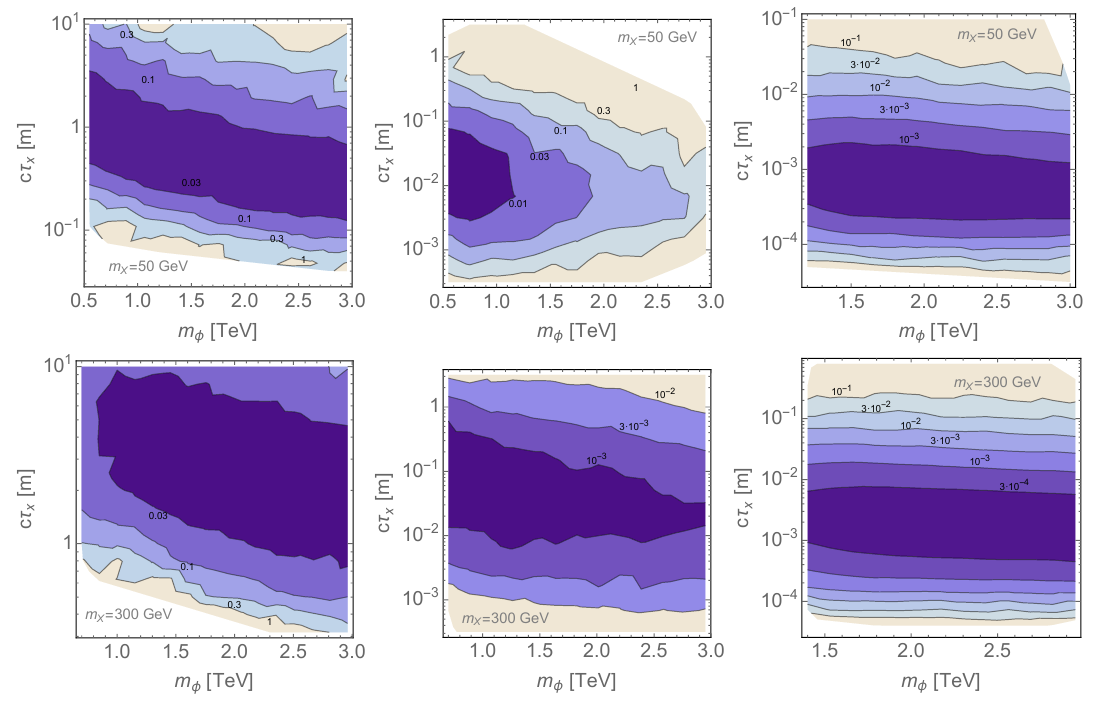
Figure 2 . Contours of the excluded signal strength (cid:27) (cid:30) (cid:1) BR in pb in the plane ( m (cid:30) , c(cid:28) X ) for the three LLP searches discussed in the text. The upper/lower rows refer to m X = 50 GeV/ m X = 300 GeV respectively. Left: ATLAS (cid:22) -RoI search at 13 TeV [32] Center: CMS IT search at 13 TeV [35]. Right: CMS beam pipe search at 13 TeV